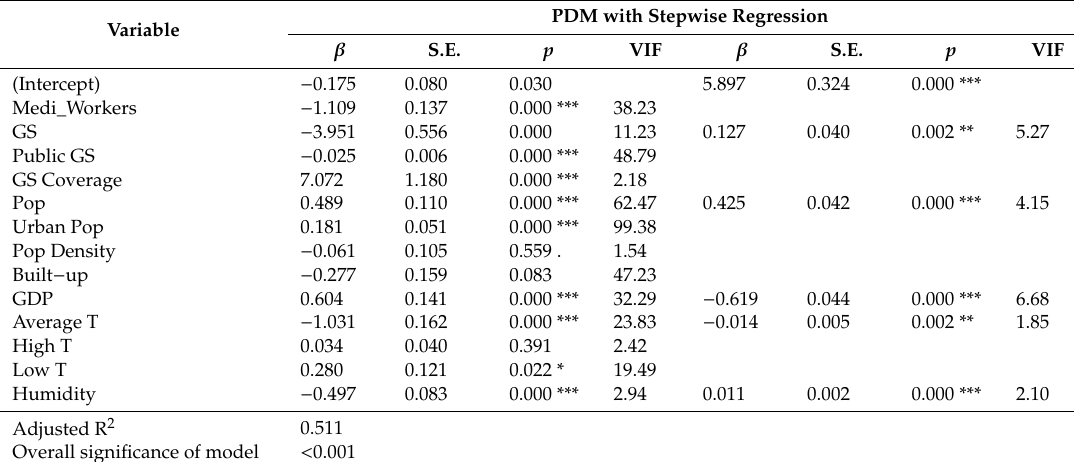
Table 4. p -values of Lagrange Multiplier Test, F Test, and Hausman Test.